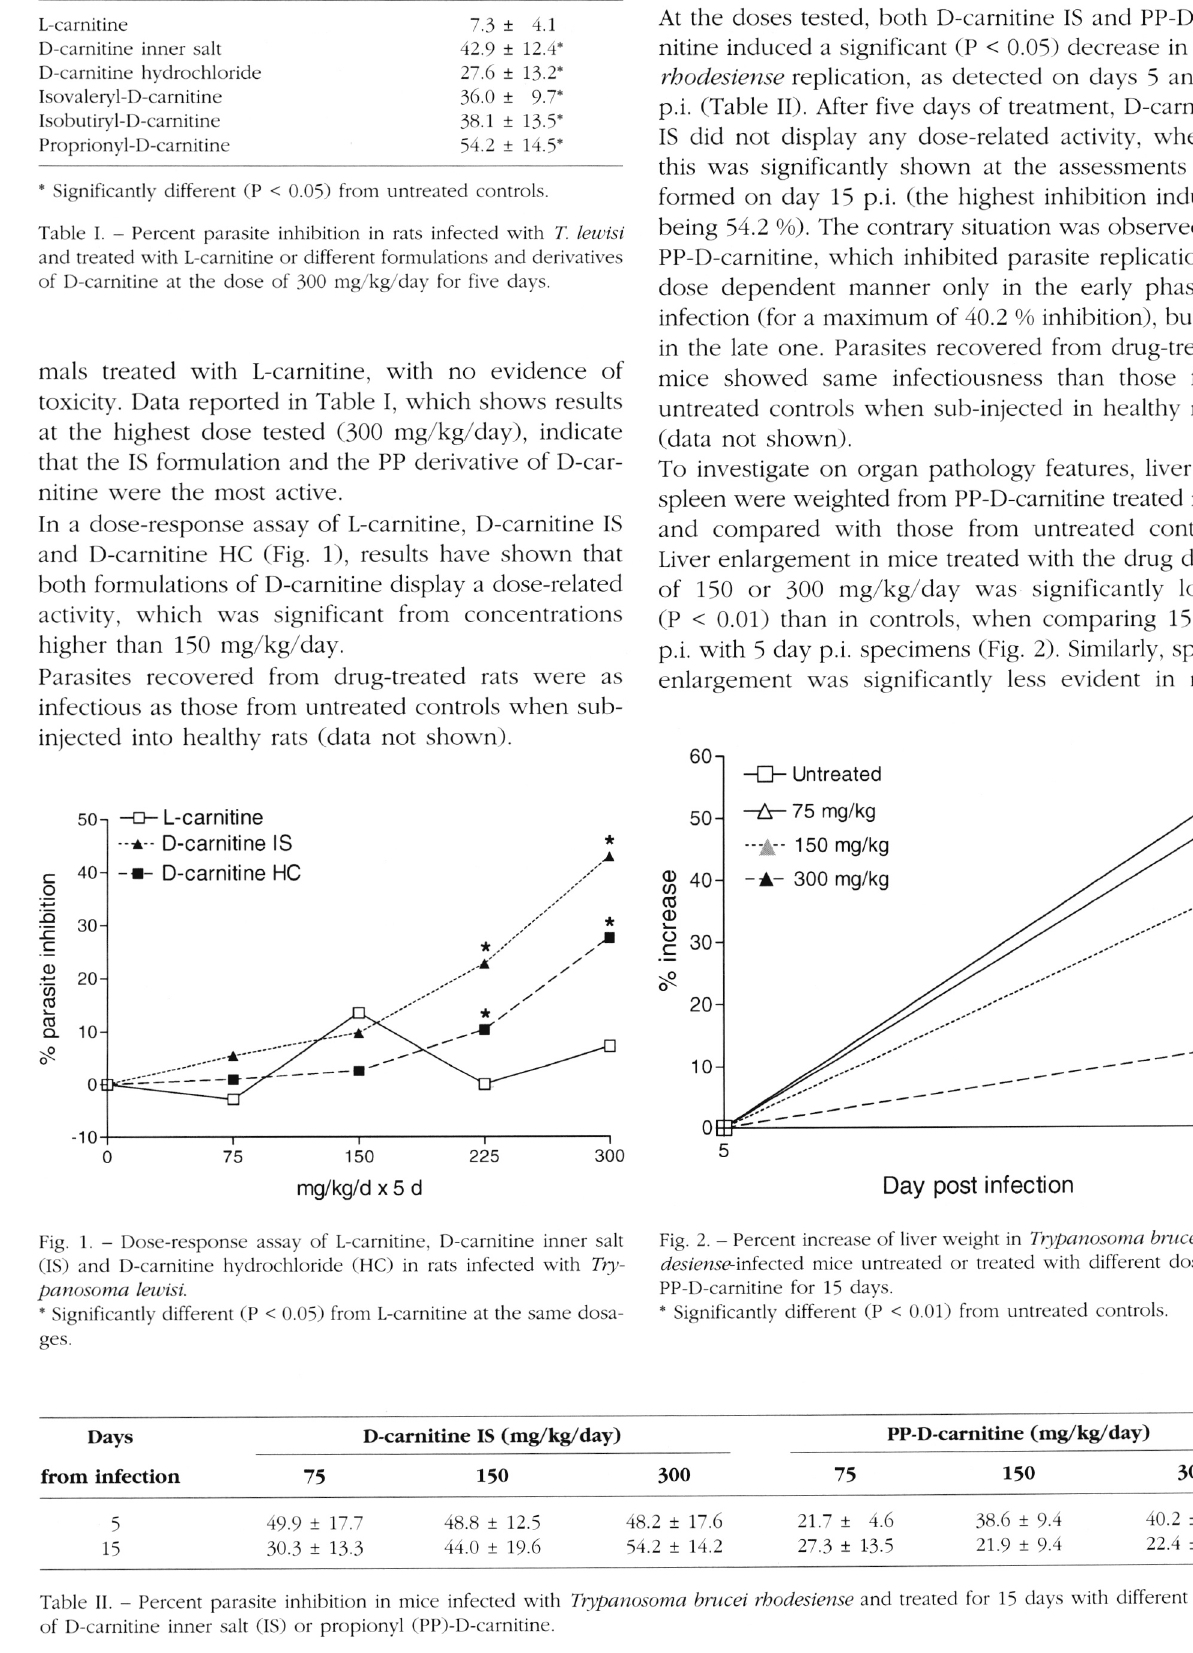
Table II. - Percent parasite inhibition in mice infected with Trypanosom a brucei rhodesiense and treated for 15 days with different doses of D-carnitine inner salt (IS) or propionyl